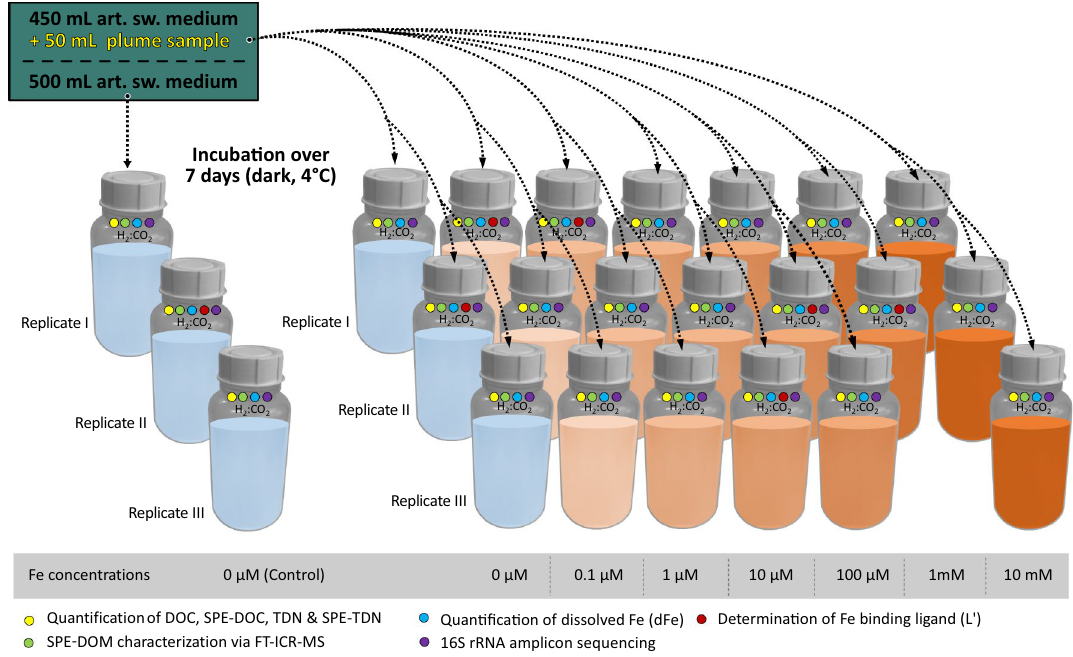
Figure 2. Design of the conducted 7-day incubation experiments. Triplicates (one replicate was lost for 1 mM Fe-level) consisting of 50 mL plume sample plus 450 mL artificial seawater medium (ASW) were set up for a range of spiked Fe-concentrations (Fe(II)SO 4 , 0 µM, 0.1 µM, 1 µM, 10 µM, 100 µM, 1 mM, and 10 mM Fe). Pure 500 mL ASW triplicates were set up as controls. After 7 days of incubation at 4 °C in the dark, the bottles were sampled for characterization of the indicated